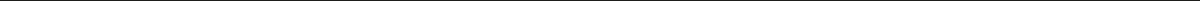
Fig. 5 CCL2-mediated IM recruitment is critical for LUSC metastasis. a Relative expression of CCL2 for KLN205 and sub-clones. b Quanti fi cation of luciferase signal. c Representative images obtained 10 days after cell injection of (i) KLN205-Scr ORF, (ii) KLN205-CCL2 ORF, (iii) LN4K1-Cntrl shR, (iv) LN4K1-CCL2 shR#1 and (v) LN4K1-CCL2 shR#2. Data are averages ± s.e.m. P -values were obtained with Student ’ s t-test, n = 10 mice/group. d Survival plots of mice following tail vein injection of KLN205 cell lines. The black arrow indicates tissue harvest, n = 10 mice/group. e Number of IMs per lung lobe, n = 12 lobes/group. f Survival plots of mice following tail vein injection of LN4K1 cell lines. The black arrow indicates tissue harvest, n = 10 mice/group. g Number of IMs per lung lobe, n = 12 lobes/group. h Schematic (left) and quanti fi cation of luciferase signal (right) of mice treated with vehicle or PF- 04136309 to assess effects on established metastases. i FACS plots and ( j ) quanti fi cation of percent IMs in the blood and ( k ) right lung of LN4K1-bearing mice. Data are averages± s.e.m. P -values were obtained with Student ’ s t-test, n = 5 mice/group. l , FACS analysis of percent immune in fi ltrates for TAMs (gated on F480), DCs (gated on SiglecF-/CD11c), CD4, CD8, Tregs (gated on TCRb + ) and NK cells (gated on SiglecF-/B220-/TCRb-). m Schematic (left) and quanti fi cation of luciferase signal (right) of mice treated at the time of cell injection to assess effects on preventing metastasis. Data are averages ± s.e. m. P -values were obtained with Student ’ s t-test, n = 10 mice/group. n.s. = non-signi fi cant, * P ≤ 0.05, *** P < 0.001. For panel b , * FDR < 0.05, ** FDR <